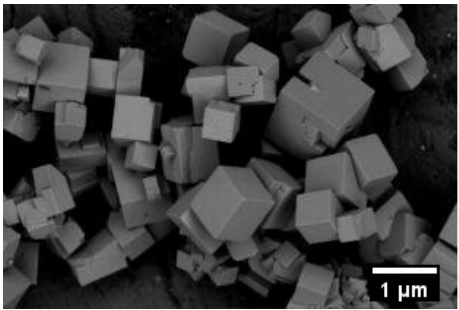
Figure 4. SEM image of pyrite after sorption with negatively charged AuNPs for 72 h (pH = 4.0).